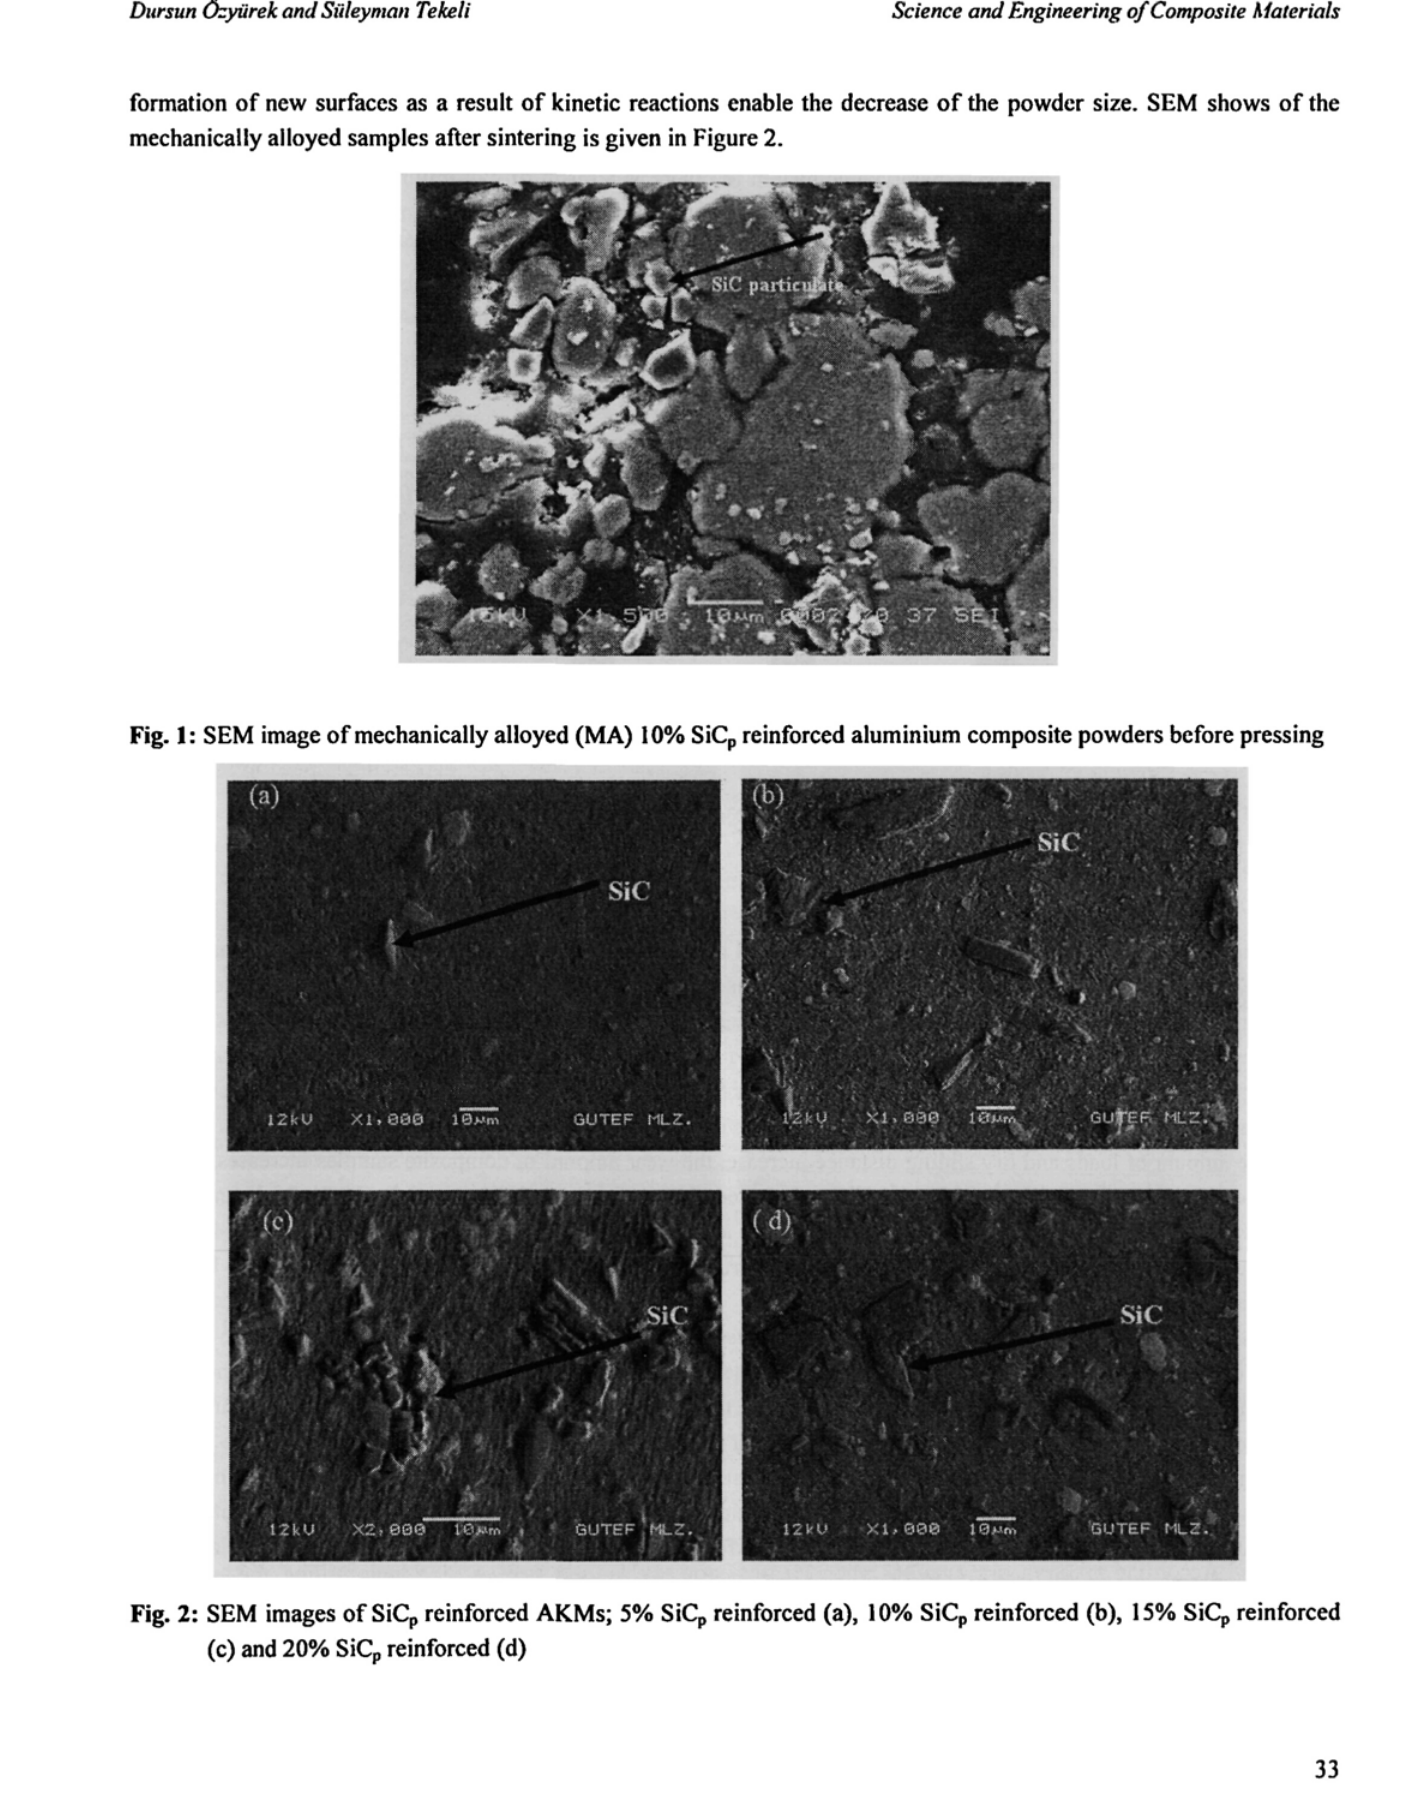
Fig. 2: SEM images of SiC reinforced AKMs; 5% SiC p (c) and 20% SiC reinforced (d) p